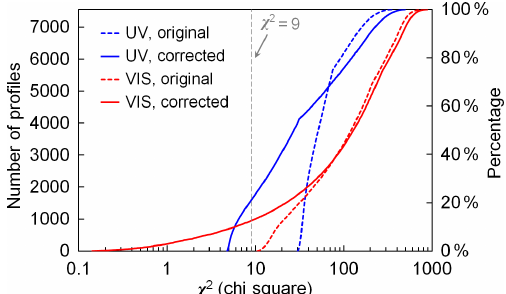
Figure 8. Cumulative distribution of the χ 2 of all the profiles in X LUT for the scanning cycle on 7 December 2015 at ∼ 13:55UTC (SZA ∼ 79 ◦ , RAA ∼ 39 ◦ ). Dashed and solid curves refer to the re- sults before and after the O 4 DSCD correction, respectively. Blue and red curves refer to the results of the UV and VIS bands, respec- tively. Note that the x axis is logarithmically